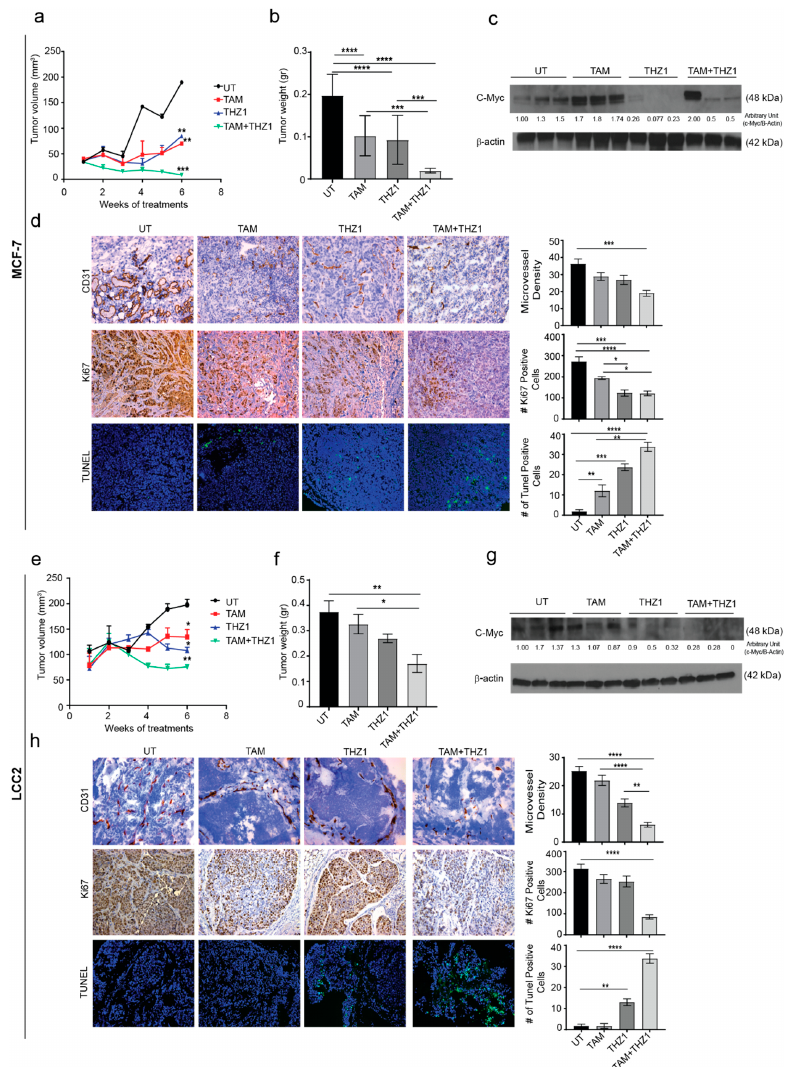
Figure 5 . In vivo therapeutic efficacy of CDK7 inhibition in combination with tamoxifen. ( a ) Tumor volume in mice bearing MCF-7 tumors treated with tamoxifen, THZ1, or their combination. ( b ) Tumor weight in mice bearing MCF-7 tumors in four treatment groups (10 mice per group): untreated (UT), tamoxifen (TAM), THZ1, and tamoxifen plus THZ1. ( c ) Western blot of c-MYC protein levels in tumor tissue from mice bearing MCF-7 tumors treated with tamoxifen, THZ1, or their combination, for quantification we used imageJ software to measure the intensity and normalize each value to its corresponding β -actin. ( d ) (Left) Representative micrographs (20 × ) showing immunohistochemical staining of CD31 and Ki67 and terminal deoxynucleotidyl transferase dUTP nick end labeling (TUNEL) assays in MCF-7 tumors from mice treated with tamoxifen, THZ1, or their combination. (Right) Quantification of microvessel density, cell proliferation, and apoptosis in the above groups. ( e ) Tumor volume in mice bearing LCC2 tumors treated with tamoxifen, THZ1, or their combination. ( f ) Tumor weight in mice bearing LCC2 tumors in four treatment groups (10 mice per group): UT, tamoxifen, THZ1, and tamoxifen plus THZ1. ( g ) Western blot of c-MYC protein levels in tumor tissue from mice bearing LCC2 tumors treated with tamoxifen, THZ1, or their combination. ( h ) (Left) Representative micrographs (20 × ) showing immunohistochemical staining of CD31 and Ki67 and TUNEL assays in LCC2 tumors from mice treated with tamoxifen, THZ1, or their combination. (Right) Quantification of microvessel density, cell proliferation, and apoptosis in the above groups. Statistical significance was determined by one-way ANOVA using the Tukey multiple comparison test. **** p < 0.0001, *** p < 0.001, ** p < 0.01, * p <